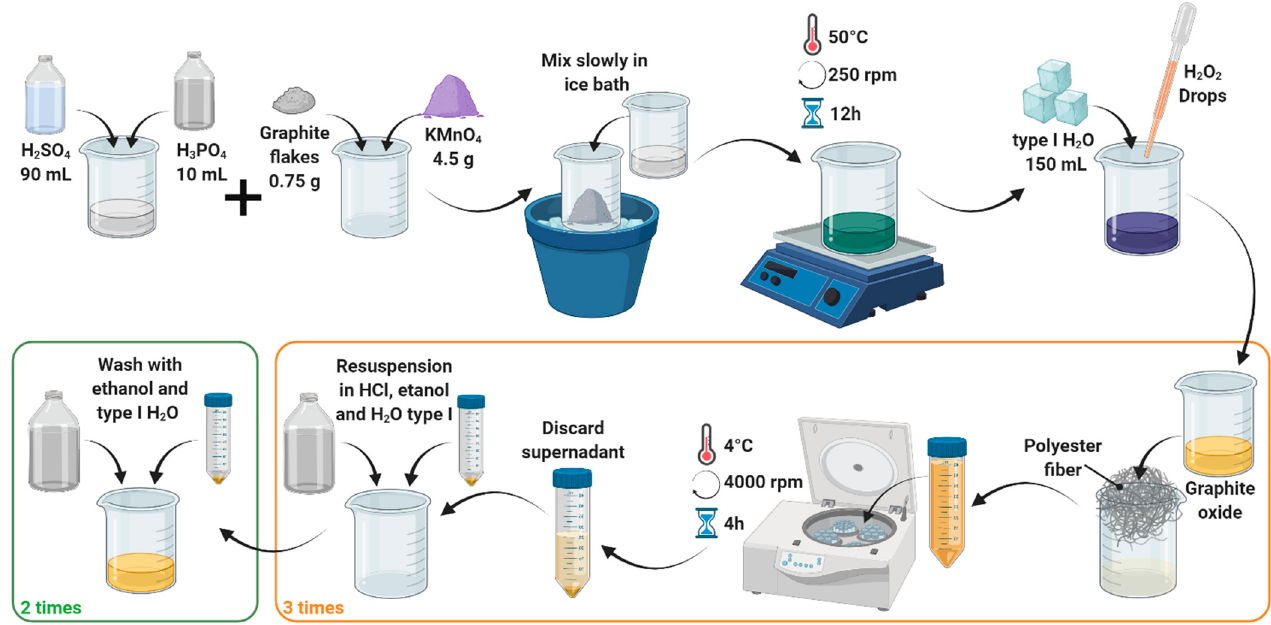
Figure 2. Synthesis of graphene oxide by the coupled exfoliation/oxidation of graphite, as described by Marcano’s modi- fication of the Tour’s